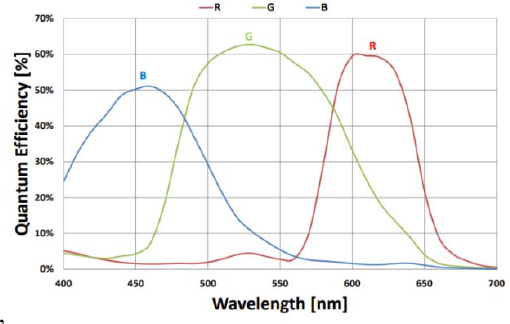
Fig. 3. Quantum efficiency of the camera sensor.